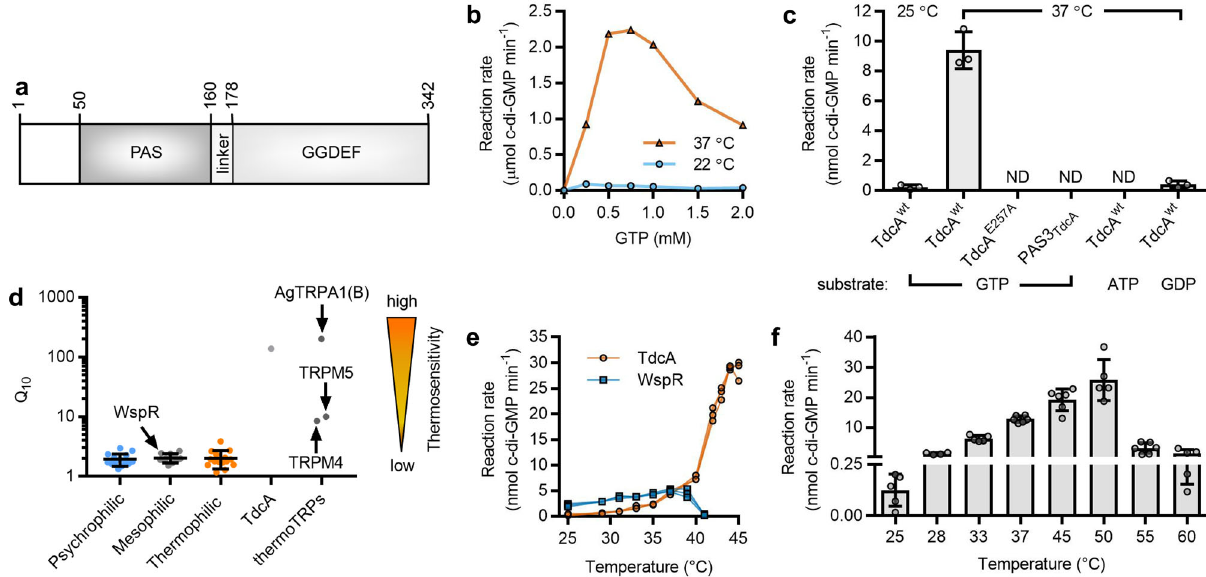
Fig. 3 TdcA displays thermosensitive catalytic activity. a Schematic illustrating the predicted domain organization of TdcA. b Substrate-dependent enzyme kinetics of His 6 -NusA-TdcA. Measurements were performed in triplicate and one independent replicate is shown. c GTP is the substrate for His 6 -MBP-TdcA. Each bar represents the mean and standard deviation of three independent replicates. ATP, adenosine-5 ʹ -triphosphate; GDP, guanosine-5 ʹ -diphosphate; GTP, guanosine-5 ʹ -triphosphate. d TdcA is an outlier to theory for universal enzymatic rate – temperature dependencies in bacteria. Each datum point represents a Q 10 value for an enzyme: Q 10 values for WspR and TdcA were calculated in the present work, whereas all other temperature coef fi cients are derived from published literature values and grouped according to the temperature-dependent activity maximum of the enzyme (psychrophilic, mesophilic, thermophilic) 72 . Lines and bars represent means and standard deviations, respectively, for 11 – 16 literature values in each category. e Temperature-dependent enzyme kinetics of His 6 -MBP-TdcA. Measurements were performed in technical triplicate and datum points and lines represent individual replicates. f LC – MS/MS measurements of temperature-dependent c-di-GMP production by recombinant His 6 -MBP-TdcA in vitro. Each datum point represents an independent replicate, and lines and bars represent means and standard deviations,